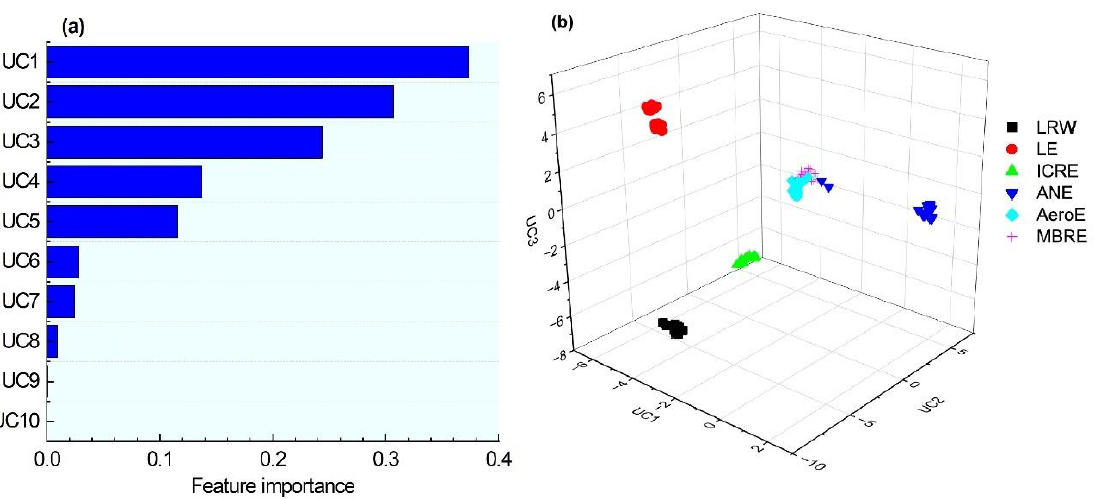
Figure 6. EN data reduction based on UMAP: ( a ) UCs ordered according the eigenvalues, ( b ) sample distributions based on the first three UCs.